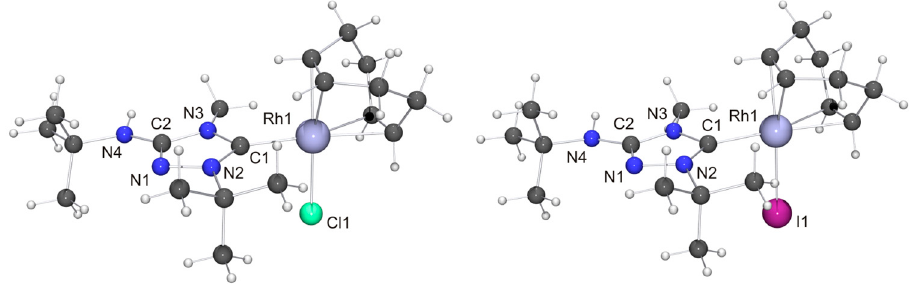
Figure 6. ( Left ) Molecular structure of [RhCl( 6 ′ )(COD)] in the crystal. Only one of the two independent molecules present in the asymmetric unit is shown. Selected bond lengths [Å] and angles [°]: C1 ‒ Rh1